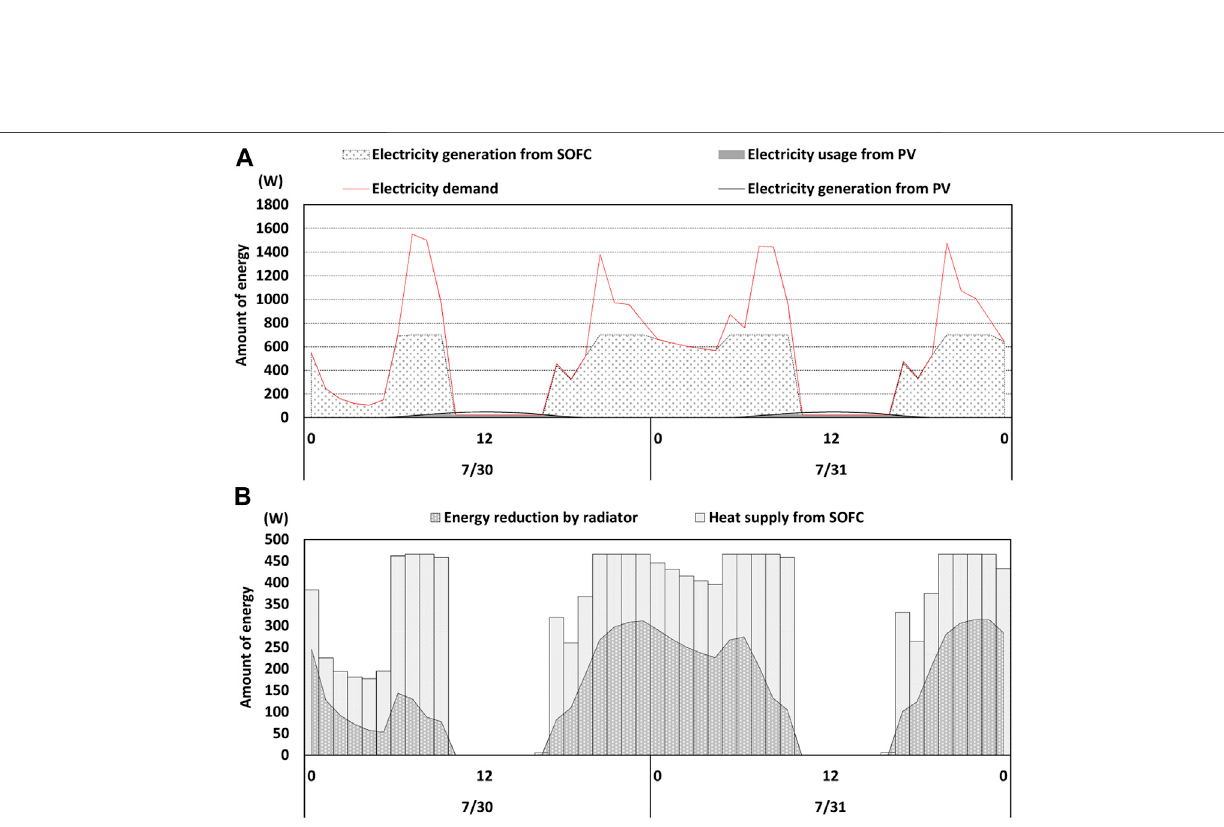
Frontiers in Energy Research |